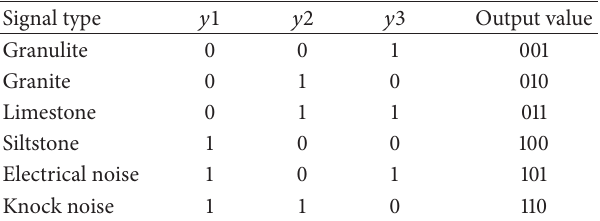
Figure 13: The convergence curve in the training. Table 4: Output parameters and their signal